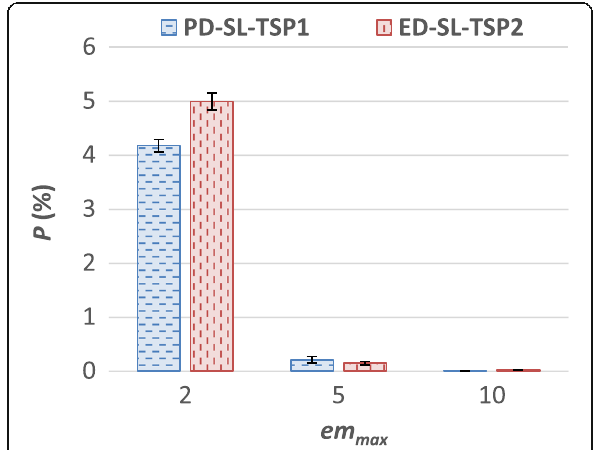
Fig. 10 Effect of em max on P when using the CyberShake workload